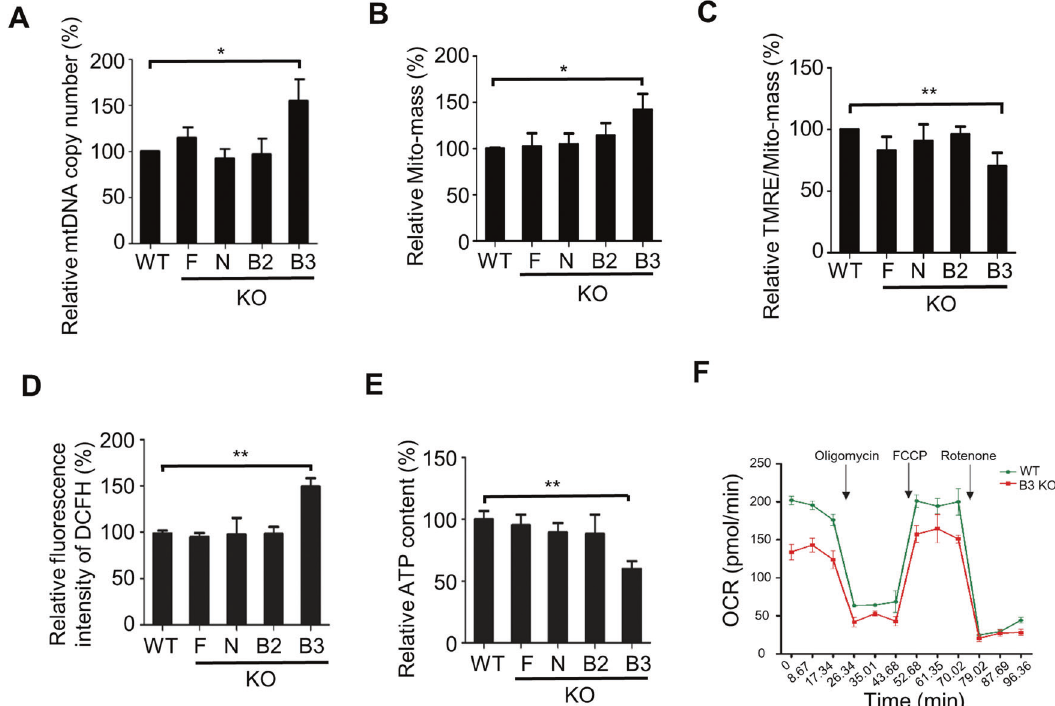
Fig. 2 BNIP3 protects mitochondrial homeostasis in mouse ESCs. A Real-time PCR analysis of mtDNA in WT and mitophagy receptor knockout ESCs. Data are shown as mean ± SD, n = 3; * P < 0.05; Student ’ s t test. B Analysis of mitochondrial mass (Mito-mass) in WT and mitophagy receptor knockout ESCs. MitoTracker Green was used for Mito-mass detection. Data are shown as mean ± SD, n = 3; * P < 0.05; Student ’ s t test. C Mitochondrial membrane potential of WT and mitophagy receptor knockout ESCs. Data are shown as mean ± SD, n = 3; ** P < 0.01; Student ’ s t test. D ROS generation in WT and mitophagy receptor knockout ESCs. Data are shown as mean ± SD, n = 3; ** P < 0.01; Student ’ s t test. E ATP generation in WT and mitophagy receptor knockout ESCs. Data are shown as mean ± SD, n = 3; ** P < 0.01; Student ’